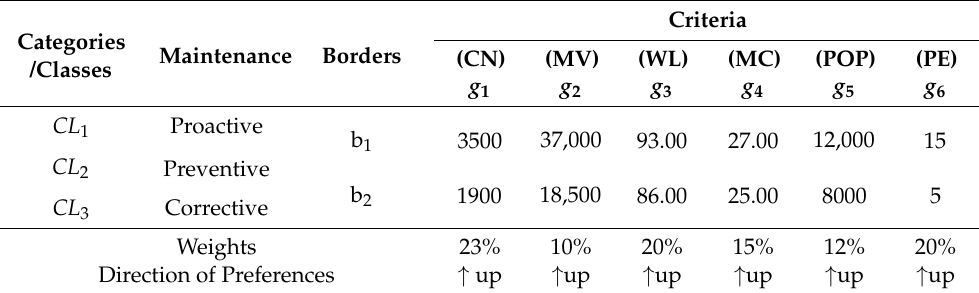
Table 3. Parameters for the boundaries between classes (original application with criteria 3 and 4 changed to